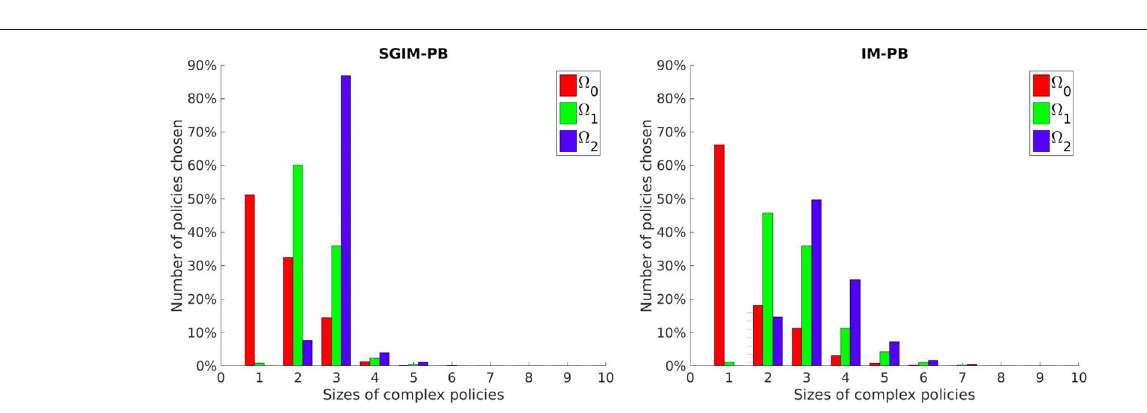
FIGURE 7 | Number of policies selected per policy size for three increasingly more complex outcome spaces by the SGIM-PB (on the left) and IM-PB (on the right)